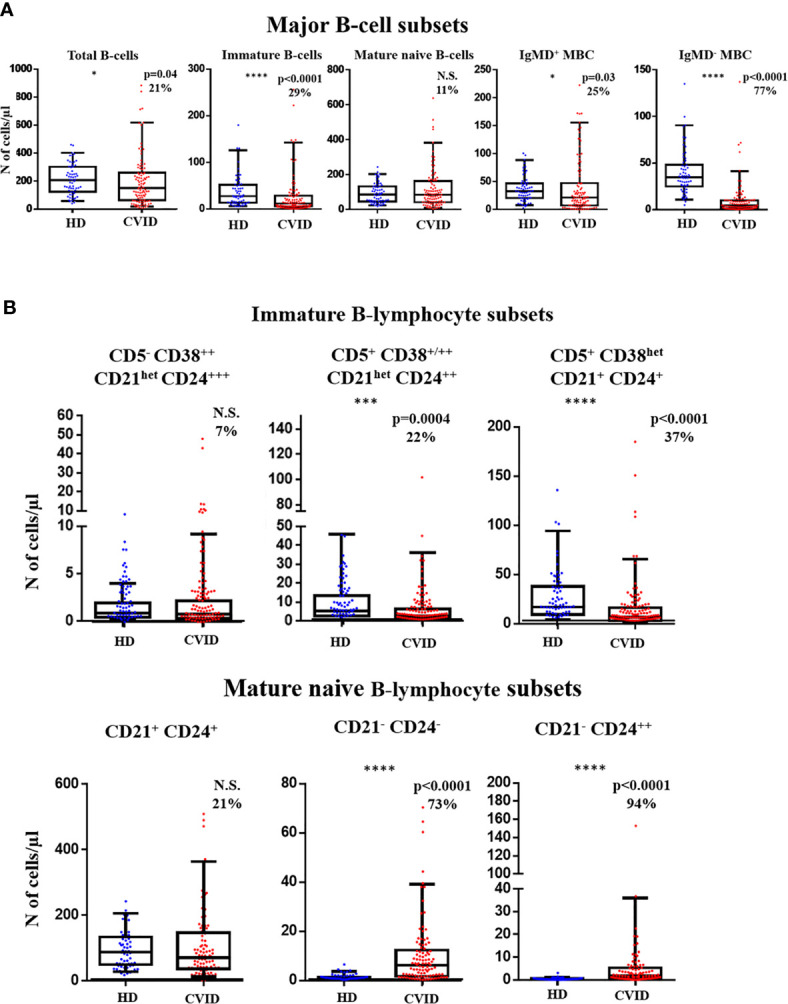
Distribution of distinct subsets of pre-germinal-center (GC) and post-GC B-cells in blood of Common Variable Immunodeficiency (CVID) patients (n=100) vs age-matched HD (n=62). (A) absolute counts of major pre-GC and post-GC B-cell subsets are shown using box and whiskers plots separately for healthy donor (HD) (n=62) and CVID patients (n=100) where horizontal lines and vertical lines represent the median and both 5th and 95th percentile values, respectively. Percentage of CVID patients with decreased or increased counts below or above normal values (<5th and >95th percentile) detected in age-matched HD are shown as percent values. (B) absolute pre-GC CD5- CD38++ CD21het CD24+++, CD5+ CD38+/++ CD21het CD24++, and CD5+ CD38het CD21+ CD24+ immature B-cell and CD21+CD24+, CD21-CD24-, and CD21- CD24++ naïve B-cell subset counts in CVID vs HD. N.S. not statistically significant differences detected, *p-value<0.05; ***p-value<0.001; ****p-value<0.0001 (Mann Whitney U test).